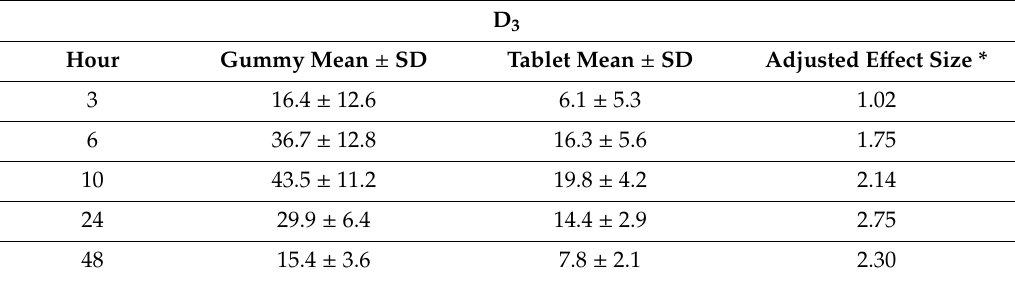
Figure 3. Time course for Study 2 of change in vitamin D 3 over time expressed as the mean ± standard deviation in ng / mL gummy vs. tablet preparation ( n = 31). Table 5. Study 2 ( n = 31). Mean ± SD changes from baseline vitamin D 3 blood concentrations (ng / mL) at each time point